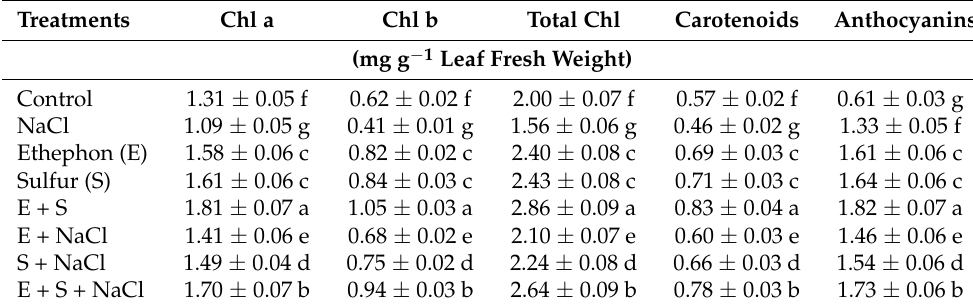
Table 4. Content of chlorophyll a (Chl a), Chl b, total Chl, carotenoids and relative amounts of anthocyanins of mustard leaves at 30 days after sowing. Plants were treated with 200 µ L L − 1 ethephon (E) and/or 200 mg S kg − 1 soil in presence or absence of 100 mM NaCl. Data are presented as means ± SE ( n = 4). Data followed by same letter are not significantly different by LSD test at p < 0.05.